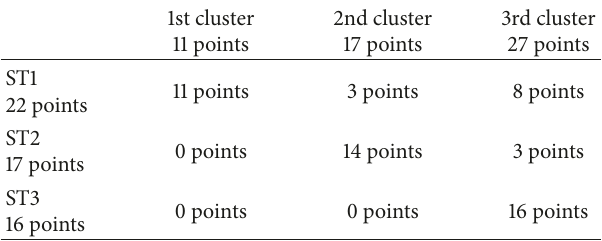
Table 3: Correspondence between the original classes and the clusters constructed by the proposed algorithm (no